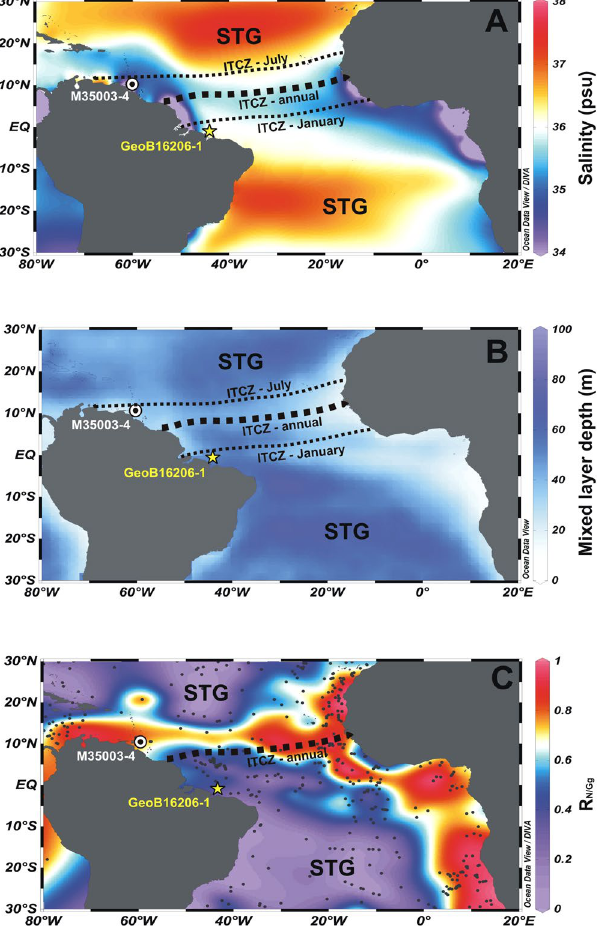
Figure 1. Tropical Atlantic Ocean maps with location of the investigated cores, upper water column properties and modern planktonic foraminifera response to the mean annual mixed layer depth. ( A ) Mean annual surface salinity (WOA 2009 29 ) and location of cores GeoB16206–1 (1°34.75 ′ S, 43°01.42 ′ W) and M35003–4 (12°5.4 ′ N/61°14.6 ′ W). The black dashed lines indicate the mean annual (thick) and seasonal (thin) position of the Intertropical Convergence Zone (ITCZ). The central portions of the subtropical gyres (STG) are indicated. ( B ) Mean annual mixed layer depth 6, 7, 49 . ( C ) Distribution of the R N/Gg ratio. Black dots represent the location of the 407 surface sediment samples 28 . Figure created using Ocean Data View software 50 (ODV - version, 4.7.4., http://odv.awi.de,